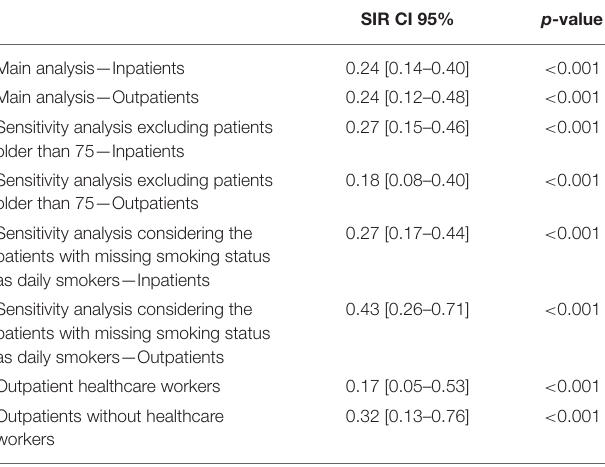
TABLE 2 | Standardised incidence ratios for daily smokers.